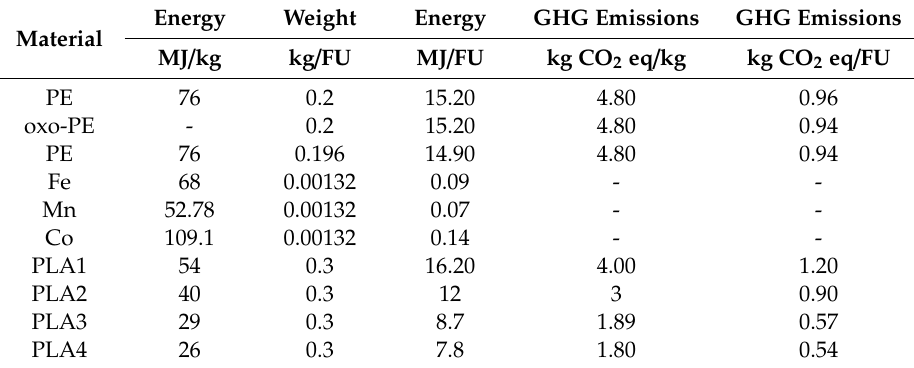
Table 3. LCA analysis for PLA and PE (energy and greenhouse gasses (GHG) emissions kg CO 2 eq)